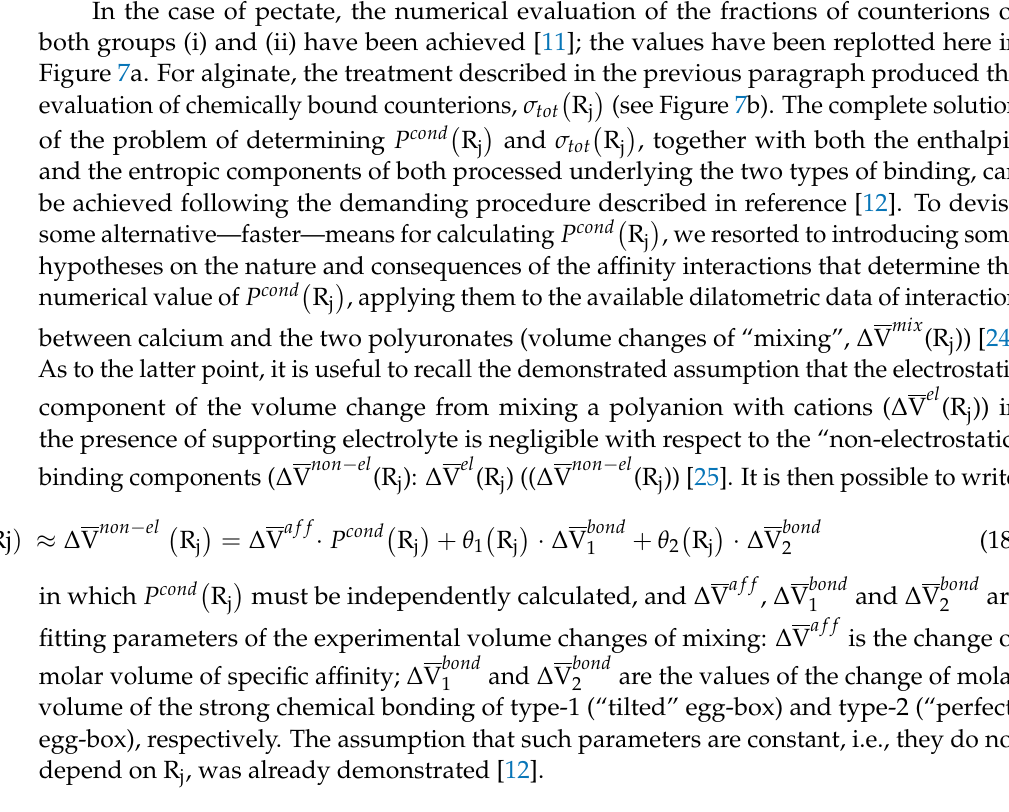
Scheme 3. ( a ) Idealized representation of the three groups of calcium ions interacting with pectate (herein sketched in the “shifted egg-box” arrangement according to reference [20]) and alginate (see text). Redrawn with permission from Scheme 1 of reference [11] (© American Chemical Society, 2021). ( b ) Representation of chemically bound counterions (group (ii) in the “perfect” egg-box configuration (blue filled circles) and of “territorially” condensed counterions (group (i), red filled circles) according to Figure 6 of reference [21]. Reproduced with permission (© American Chemical Society, 2007).